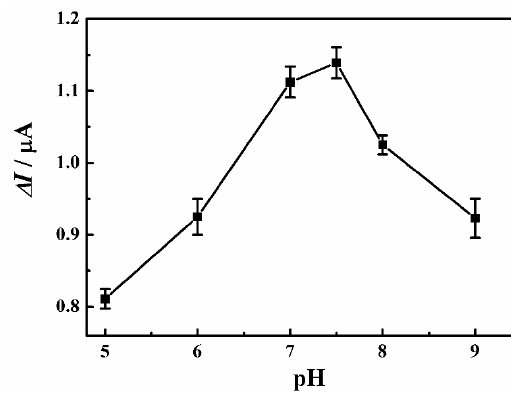
Figure 6. Influence of the pH value on the current response of the imprinted sensor towards AFP at the concentration of 1.0 ng mL − 1 .